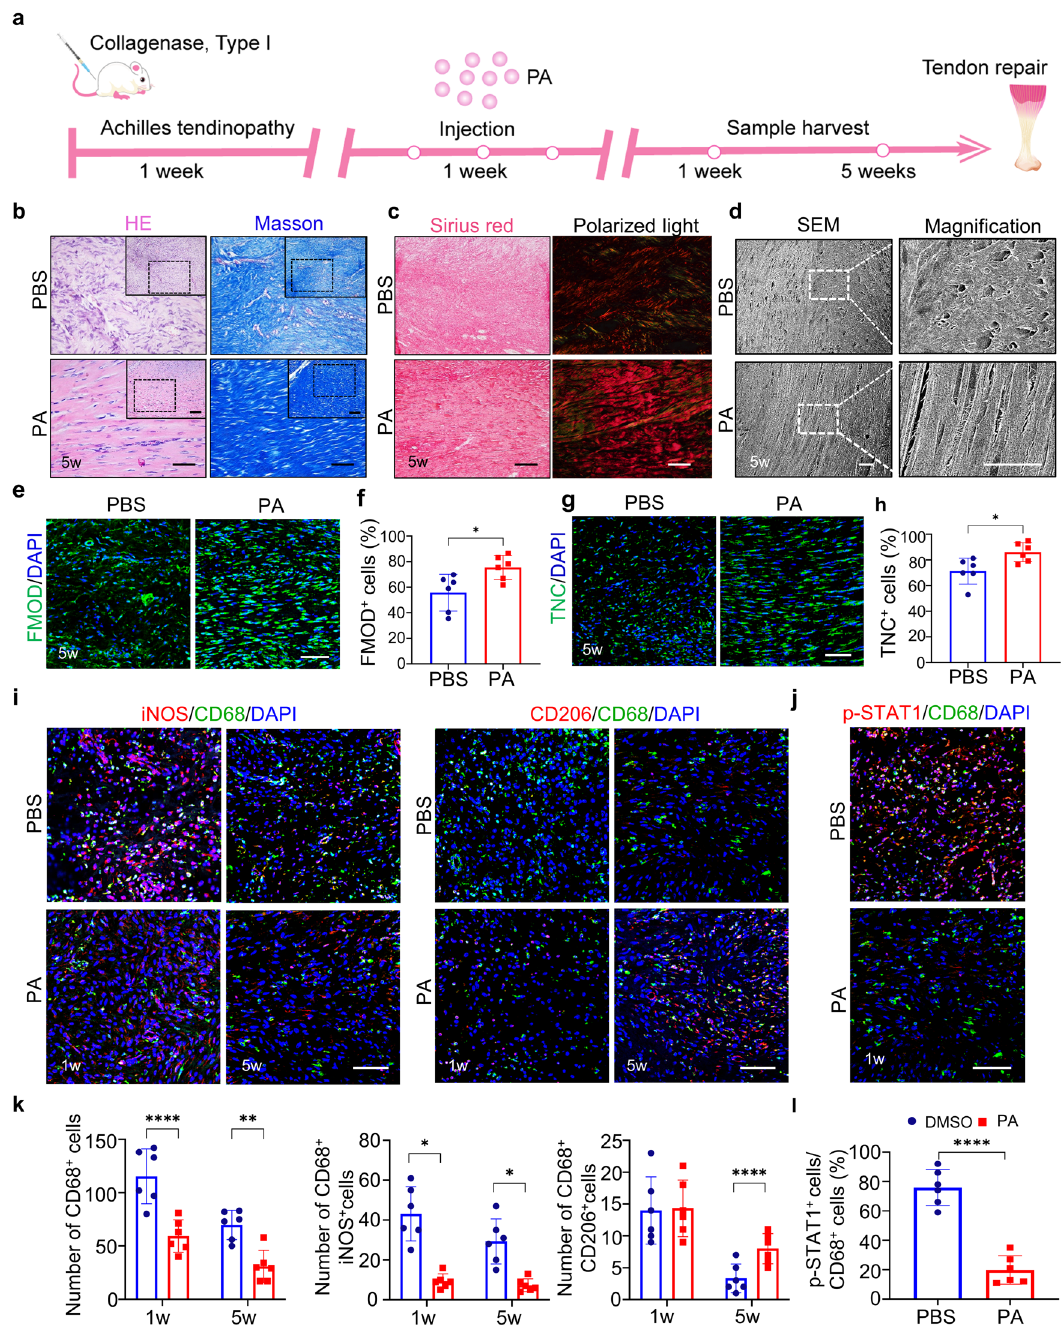
Fig. 2 PA alleviates collagenase-induced tendinopathy by inhibiting in fl ammatory response. a Schematic illustration of the experimental animal procedure. b HE and Masson ’ s trichrome staining of neo-tendons from PBS and PA groups at 5 weeks. Scale bar, 100 μ m. c Representative Sirius red staining and polarized light images showing the collagen type in neo-tendons from PBS and PA groups at 5 weeks. (Green, type III collagen; red, type I collagen). Scale bar, 100 μ m. d SEM of collagen pattern of newly-formed tendon collagen fi brils in each group at 5 weeks. Scale bar, 40 μ m. e Immuno fl uorescence staining of tenogenic marker FMOD in neo-tendons from PBS and PA groups at 5 weeks. Scale bar, 100 μ m. f Semi-quanti fi cation of e . g Immuno fl uorescence staining of tenogenic marker TNC in neo-tendons from PBS and PA groups at 5 weeks. Scale bar, 100 μ m. h Semi-quanti fi cation of ( g ). i Co-immuno fl uorescence staining of iNOS and CD68, and CD206 and CD68 in neo-tendons from PBS and PA-treated groups at 1 week and 5 weeks. Scale bar, 100 μ m. j Immuno fl uorescence staining of p-STAT1 and CD68 in 1w neo-tendons from PBS and PA-treated groups at 1 week. Scale bar, 100 μ m. k Semi-quanti fi cation of total CD68 + , iNOS + CD68 + and CD206 + CD68 + cells in ( i ). l Semi-quanti fi cation of ( j ). Data are presented as mean ± SD. * p < 0.05, ** p < 0.01 and **** p < 0.0001, n = prevented tendon heterotopic ossi fi cation (Fig. 3c, Supplementary with PA signi fi cantly reduced mineral density with a bone volume Fig. 5a). Immuno fl uorescence showed lower expression of of ~0.42 mm 3 (Fig. 3a, b). Furthermore, HE, Masson ’ s trichome, chondrocyte markers, collagen II and aggrecan were found in Alcian blue, and Safranin O stainings revealed typical endochon- the PA group compared to the PBS group (Fig. 3d). Interestingly, dral ossi fi cation in the PBS group, whereas PA treatment